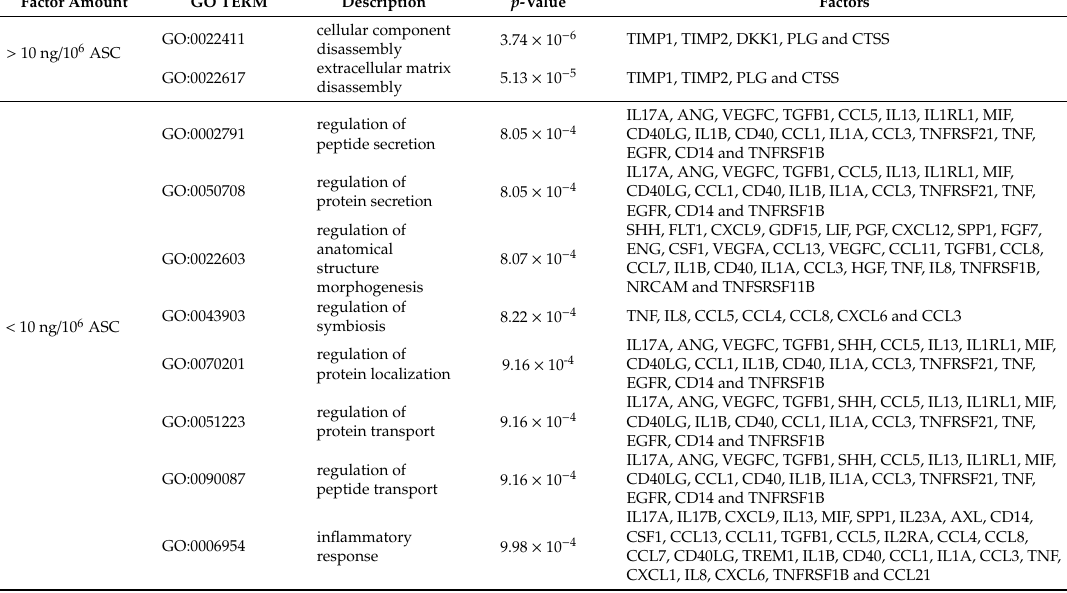
Figure 3. A visualization of the biological process gene ontology annotations using Gorilla for identified secreted factors. A ) The background dataset used is composed of 200 human factors tested in the ELISA arrays (see Materials and Methods). Enrichment using the 18 factors expressed at > 10 ng per 10 6 ASCs is shown. B ) Enrichment using the 57 factors expressed at < 10 ng per 10 6 ASCs is shown. The Gorilla settings were left at default values: p -value threshold of p < 10 − 3 , organism Homo sapiens. Table 2. Enriched gene ontology (GO) terms for secreted